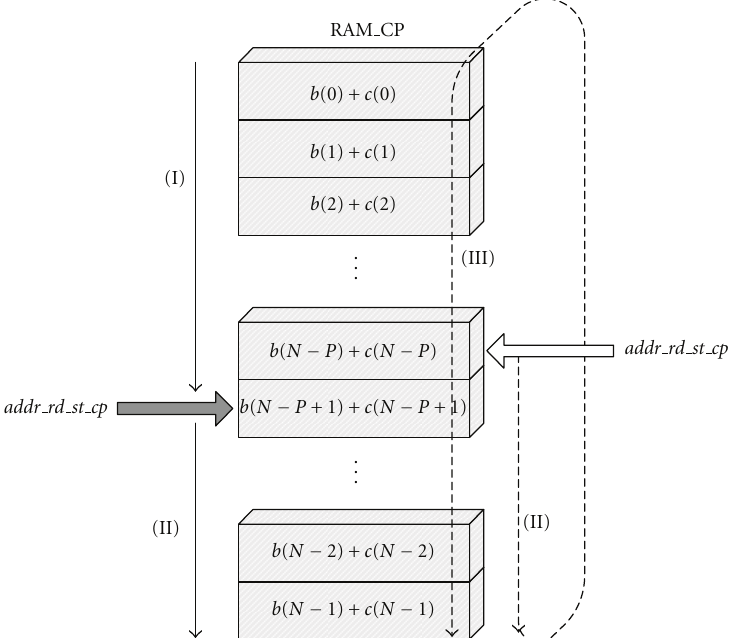
Figure 6: ST cyclic prefix generation and insertion